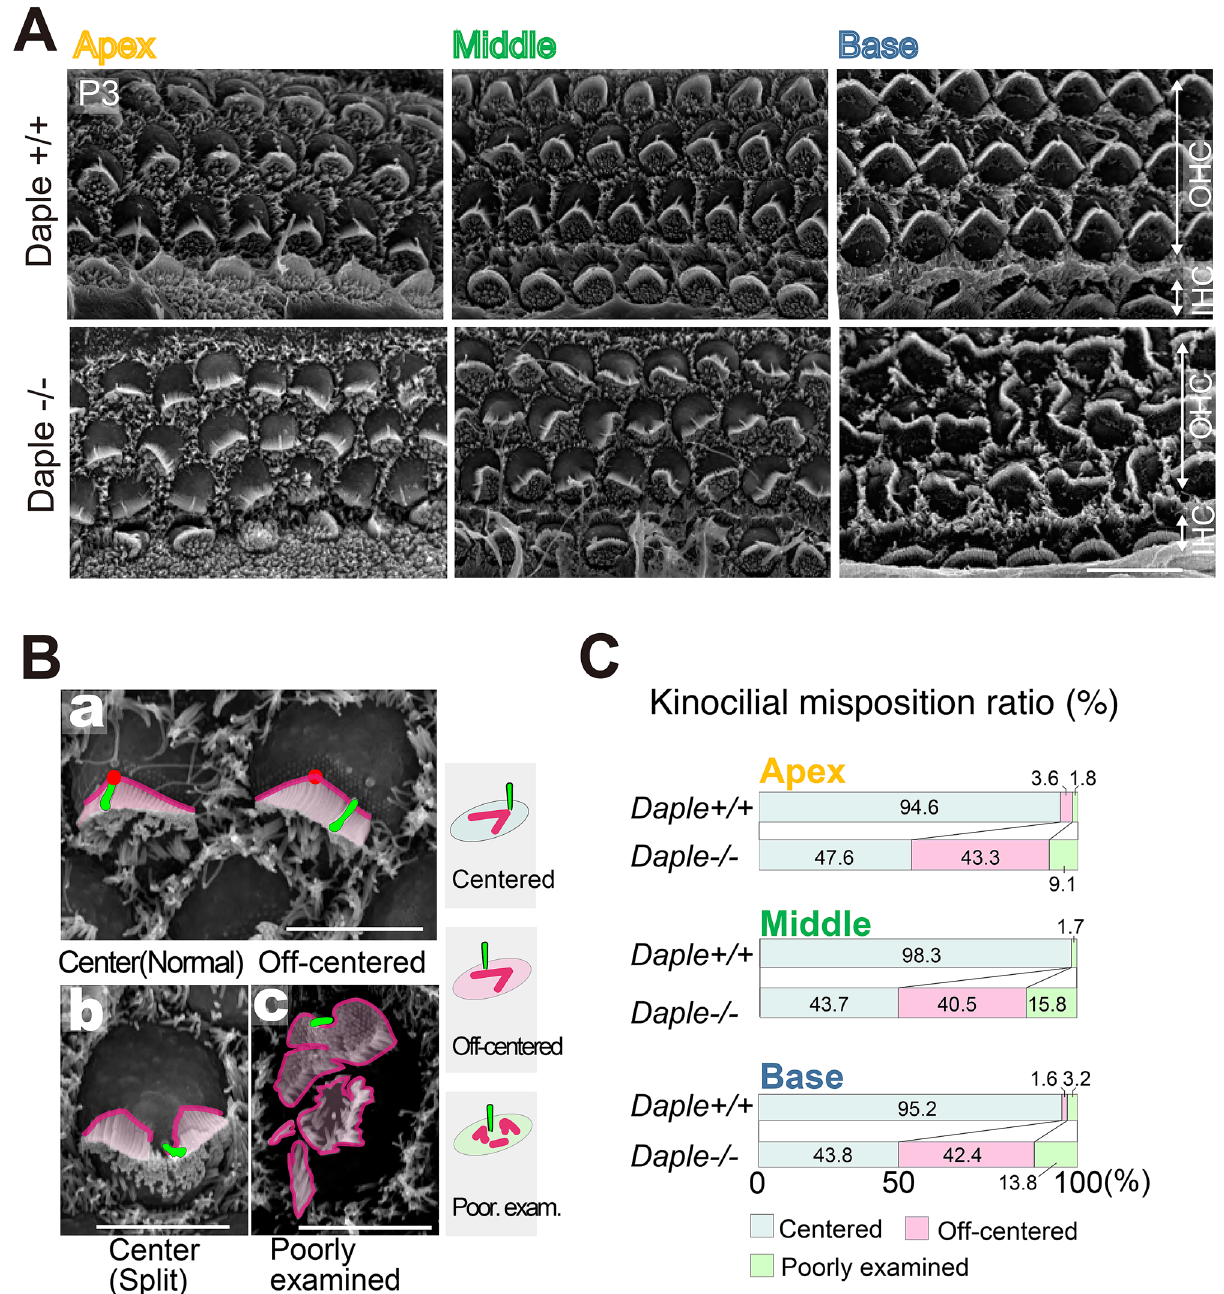
Figure 3. Analysis of Daple-deficient organ of Corti (OC) in mouse pups. ( A ) Scanning electron microscopy images of hair cells (HCs) from the apex, middle, and basal areas of Daple +/+ and Daple −/− cochleae in P3 mice. The most severe effects of Daple deficiency were observed in the basal areas of cochlea. ( B a) Normal V-shaped bundles in Daple −/− mice: left HC showed normal kinocilium locations and right HC showed abnormal kinocilium locations. ( B b) Split and ( B c) poorly examined bundles: the stepwise arrangement of stereocilia bundles was missing. ( C ) We classified the localization of kinocilia against hair bundles into three groups: normal (centered), off-centered, and poorly examined. When we could not define the kinocilia, we classified them into the poorly examined group. Over half of Daple −/− kinocilia in all three areas are off-centered (at P3, n = 5; apex 691 cells, middle 886 cells, basal 765 cells). Scale bars: ( A ); 10 μm, ( B )–( D ); 5